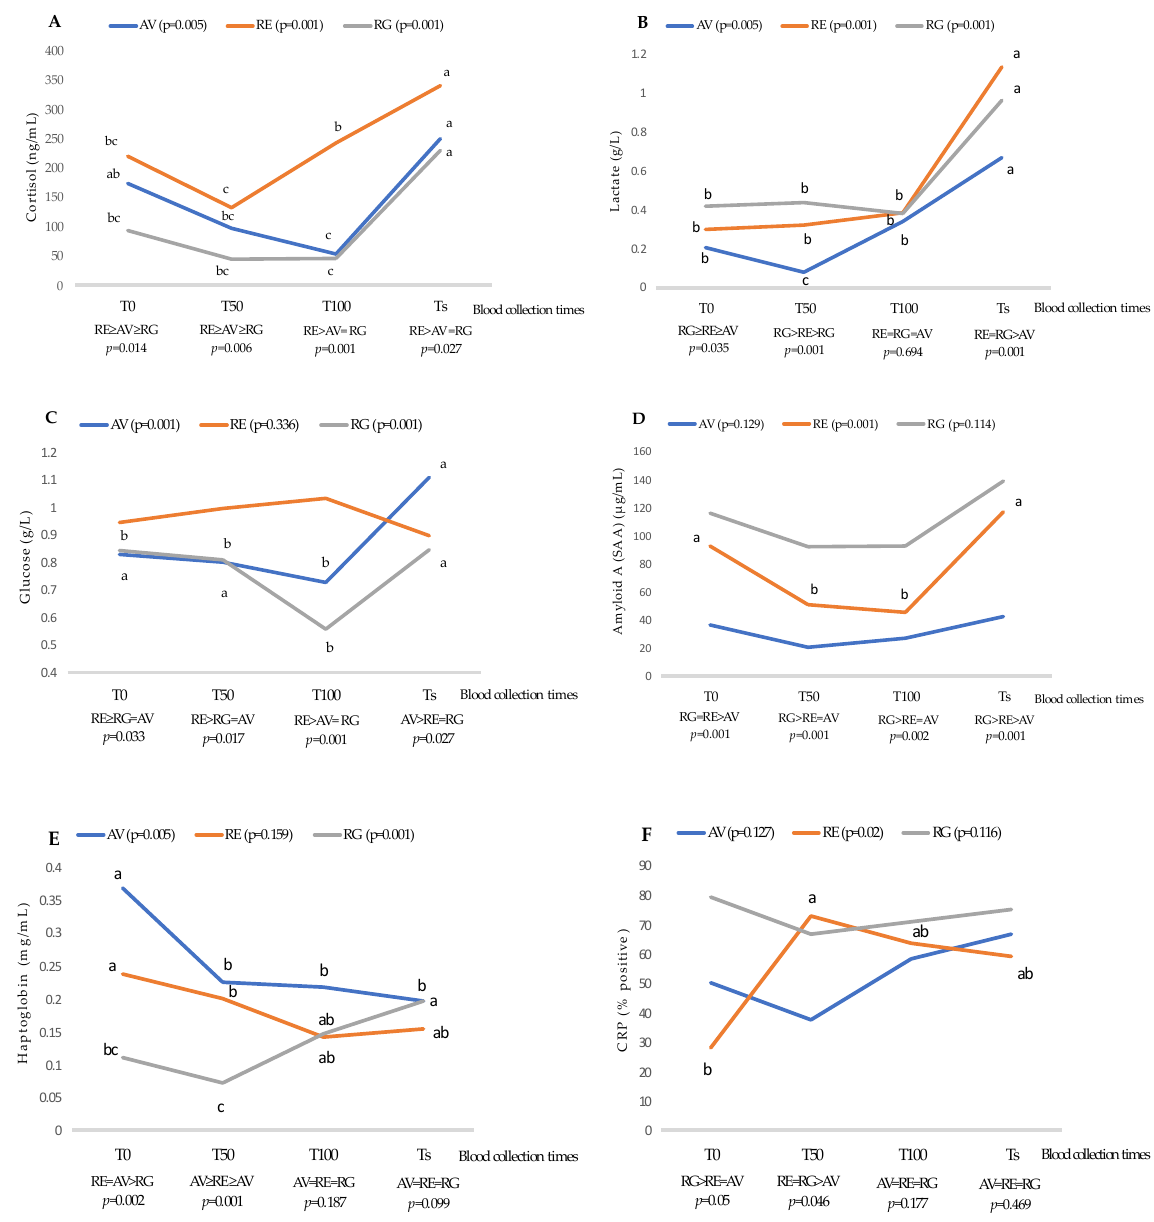
Figure 4. Effect blood collection times by breeds on ( A ) cortisol, ( B ) lactate, ( C ) glucose, ( D ) serum amyloid A, ( E ) haptoglobin, and ( F ) CRP (C reactive protein). AV: Asturiana de los Valles breed ( n = 24); RE: Retinta breed ( n = 22); RG: Rubia Gallega breed ( n = 32); T0: Weaning and starting of the fattening period; T50: Half time of the fattening period; T100: Final fattening period; Ts: Blood samples were collected during exsanguination. Within each breed, different letters mean significant differences between the studied blood collection times for p = 0.05 according to Tukey’s test.